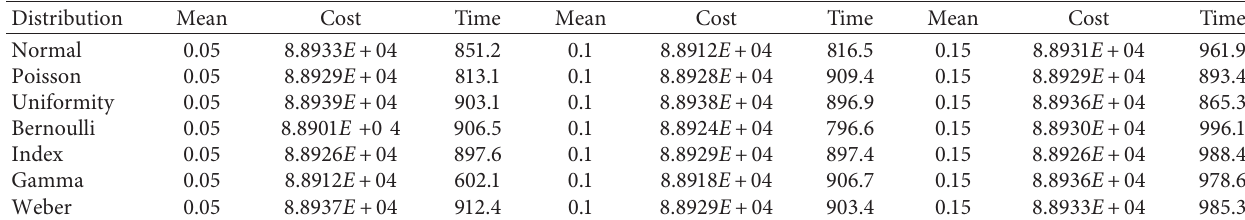
Table 4: Results of TS-SCC